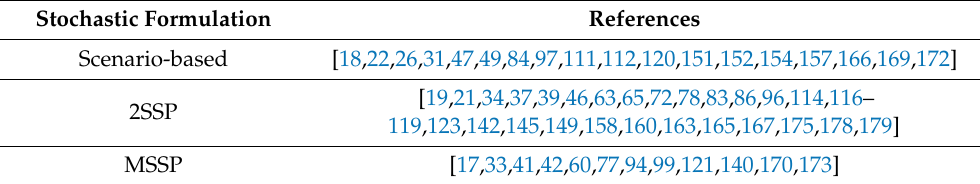
Table 3. Classification of stochastic programming mathematical formulations. Stochastic Formulation